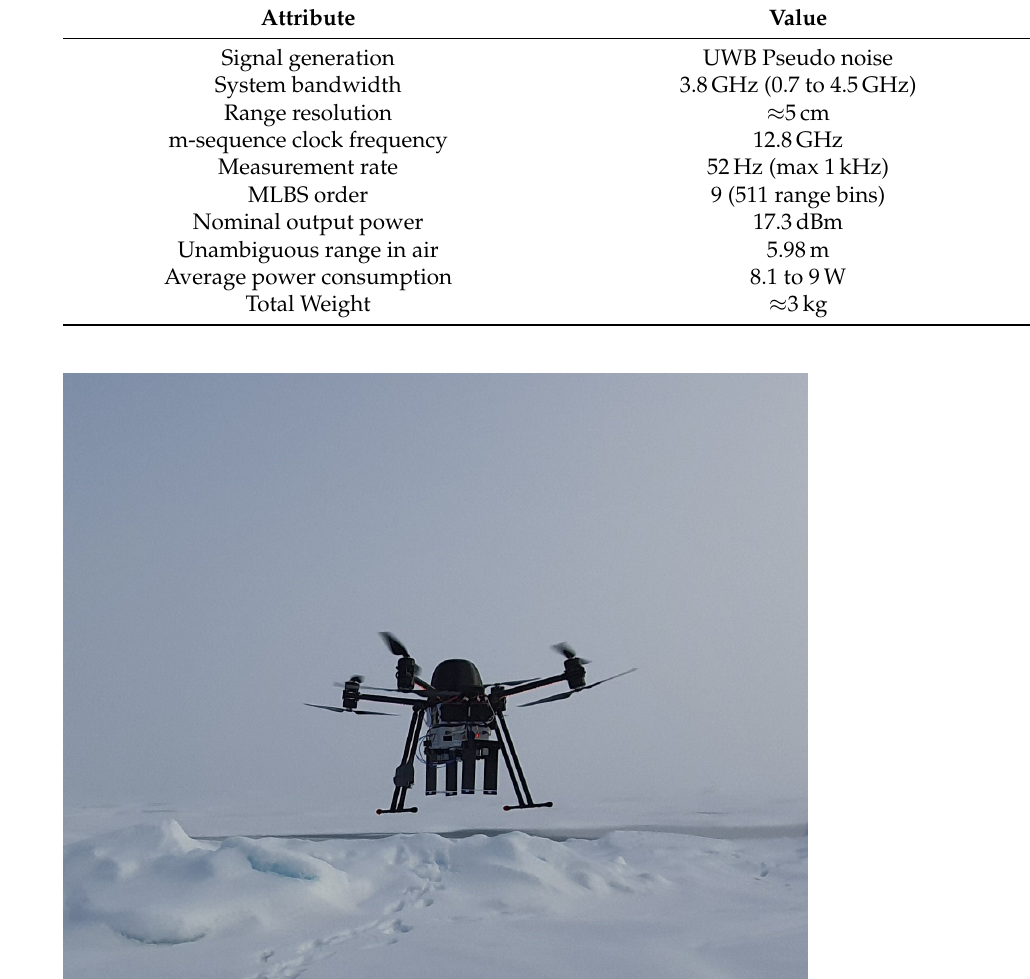
Table 1. UWiBaSS key characteristics.